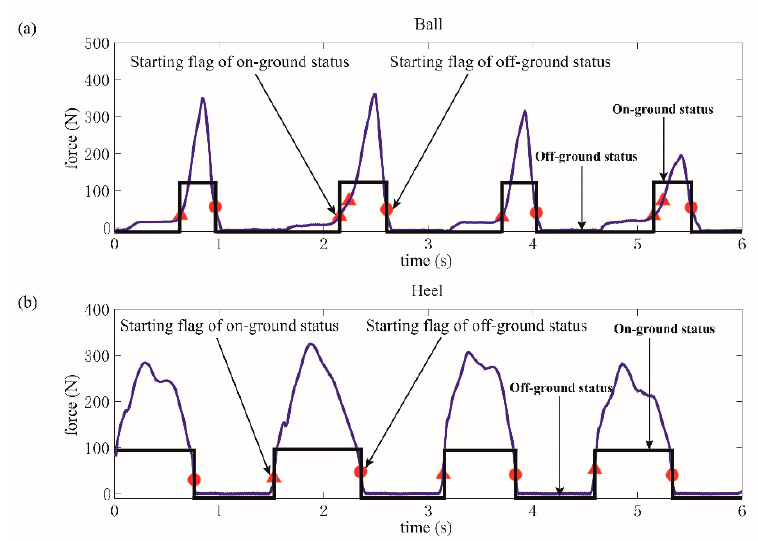
Figure 8. Status division for ball and heel. ( a ) GCFs and status division for the ball, ( b ) GCFs and status division for the heel.